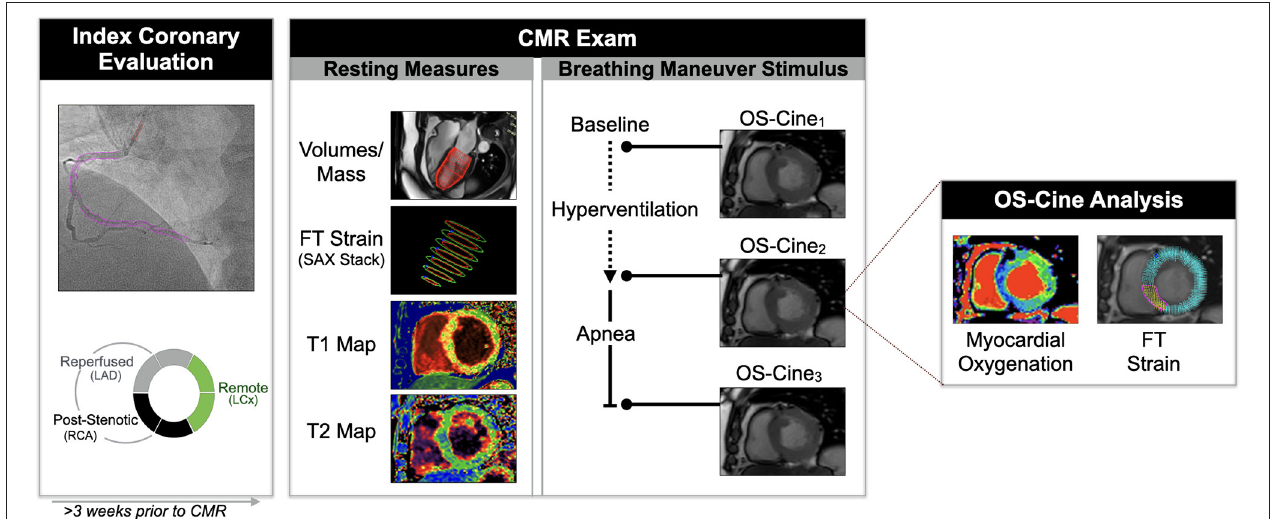
FIGURE 1 | Study methods. From the angiography images, quantitative coronary angiography was used to calculate the diameters stenosis of all coronary territories and the myocardial segments were categorized as post-stenotic, reperfused or remote territory based on the individual coronary anatomy. A contrast-free CMR exam was performed at least 3 weeks after the index angiography. Common functional and tissue characterization sequences were acquired at rest, and an oxygenation-sensitive (OS)-cine was acquired repetitively during a breathing maneuver stimulus. From the OS-cine both signal intensity changes indicating the myocardial oxygenation response and feature tracking (FT) strain parameters were measured for the global myocardium, and per myocardial